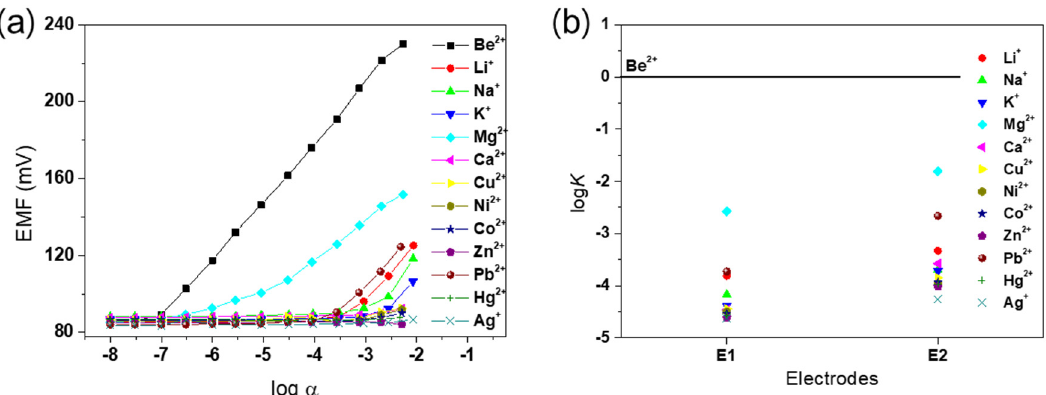
Figure 3. ( a ) Calibration curve of the fabricated Be 2+ ion-selective electrode (ISE), consisting of the potentiometric response of E1 for various metal cations. ( b ) Potentiometric selectivity coefficients (cid:3043)(cid:3042)(cid:3047) ) for E1 and E2 ( log𝐾 (cid:3003)(cid:3032) (cid:3118)(cid:3126) ,(cid:3014) (cid:3289)(cid:3126)